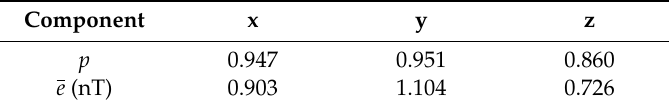
Table 2. Evaluation